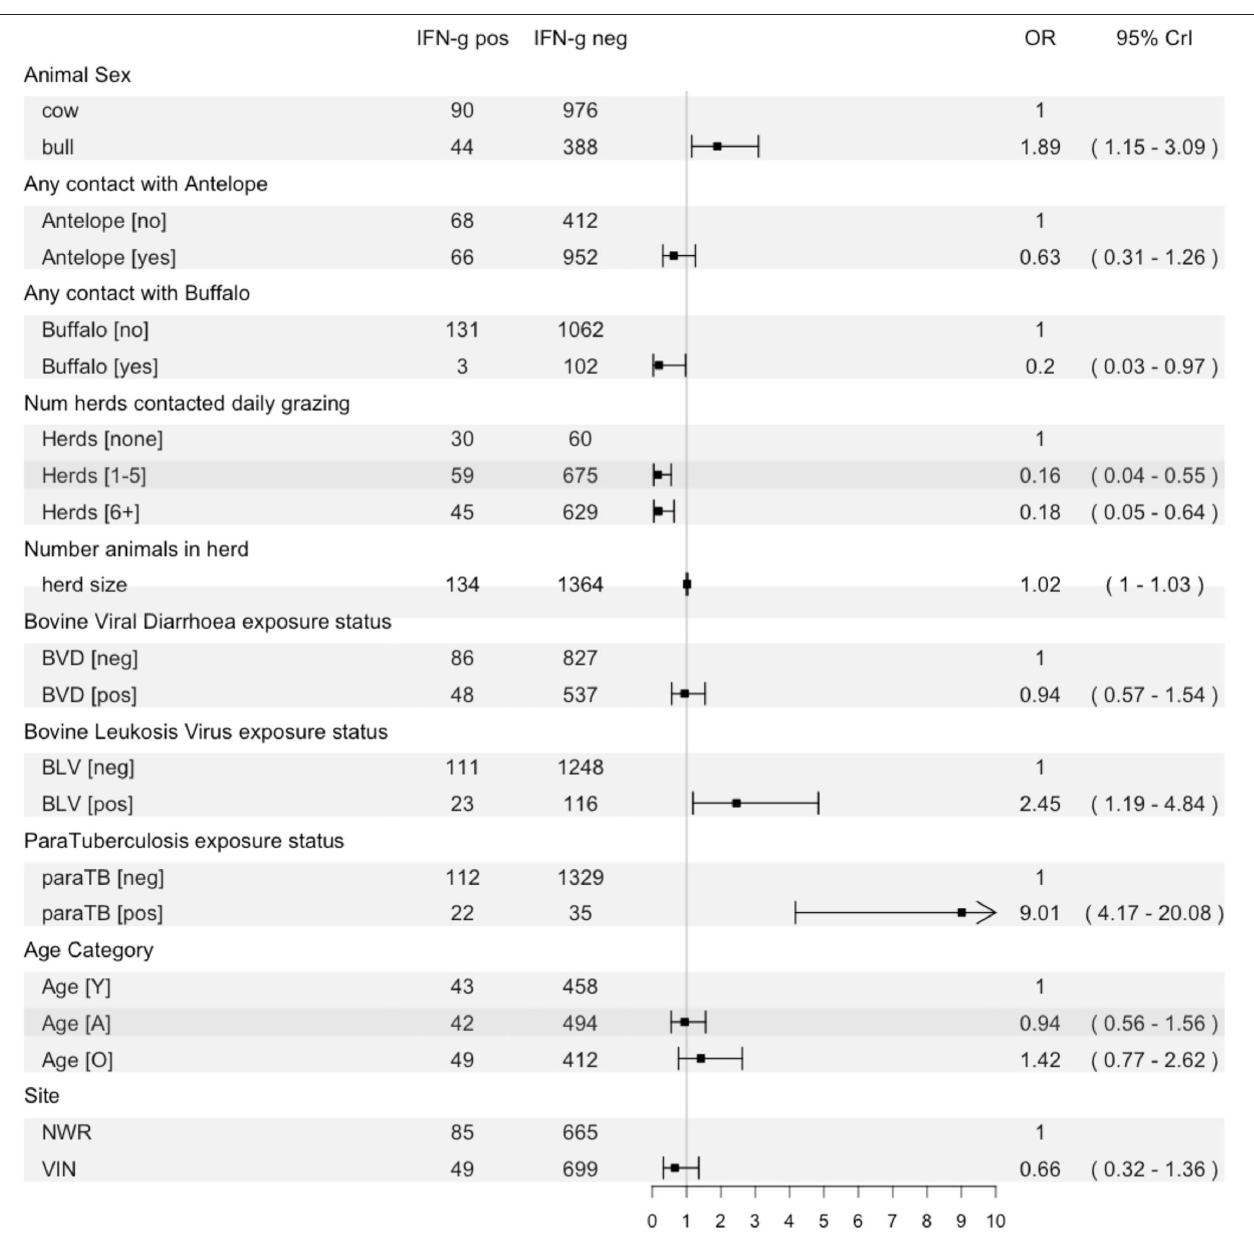
FIGURE 6 | Forest plot showing the fixed effects in the final multilevel model of risk factors for IFN- γ positivity with the raw counts for each variable, a plot of the odds ratio with 95% CrI and the numeric result and